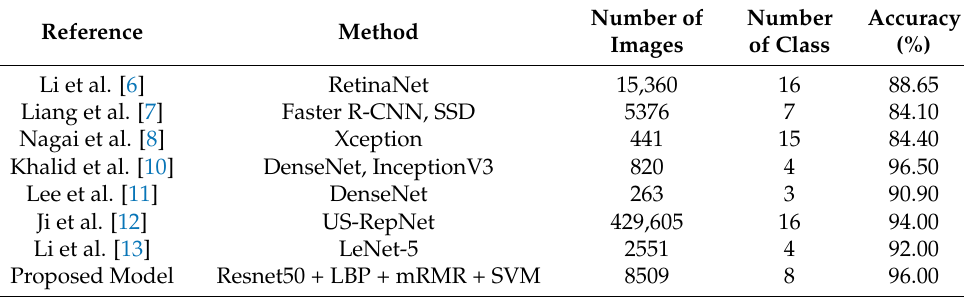
Table 7. Studies in the literature on the classification of urine particle